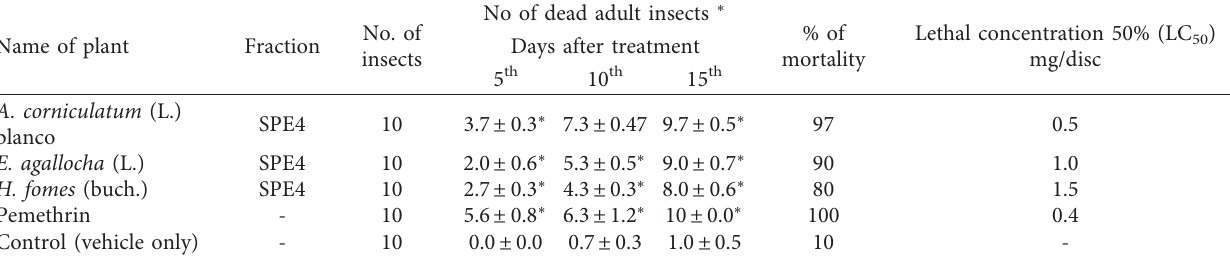
Table 3: Insecticidal activity of the SPE4 fractions of A. corniculatum, E. agallocha, and H. fomes against S. oryzae insect at 2.0mg/disc and their LC 50 .